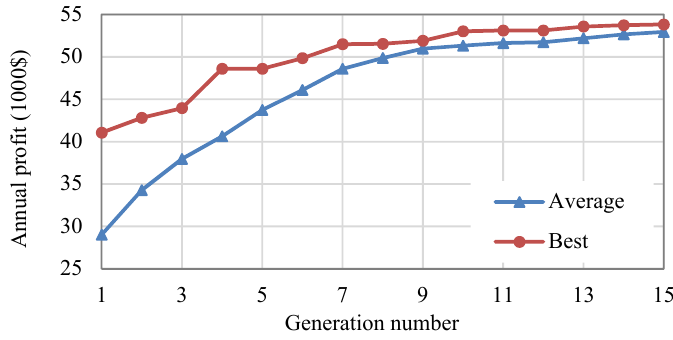
Figure 8. Profit convergence using genetic algorithm (GA) optimization.